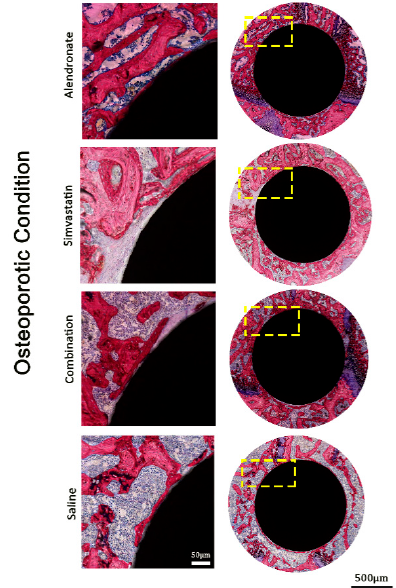
Figure 2. Representative histological images stained with methylene blue and basic fuchsin, showing non-decalcified (pMMA embedded) cross-sections of saline group in both osteoporotic and healthy conditions.